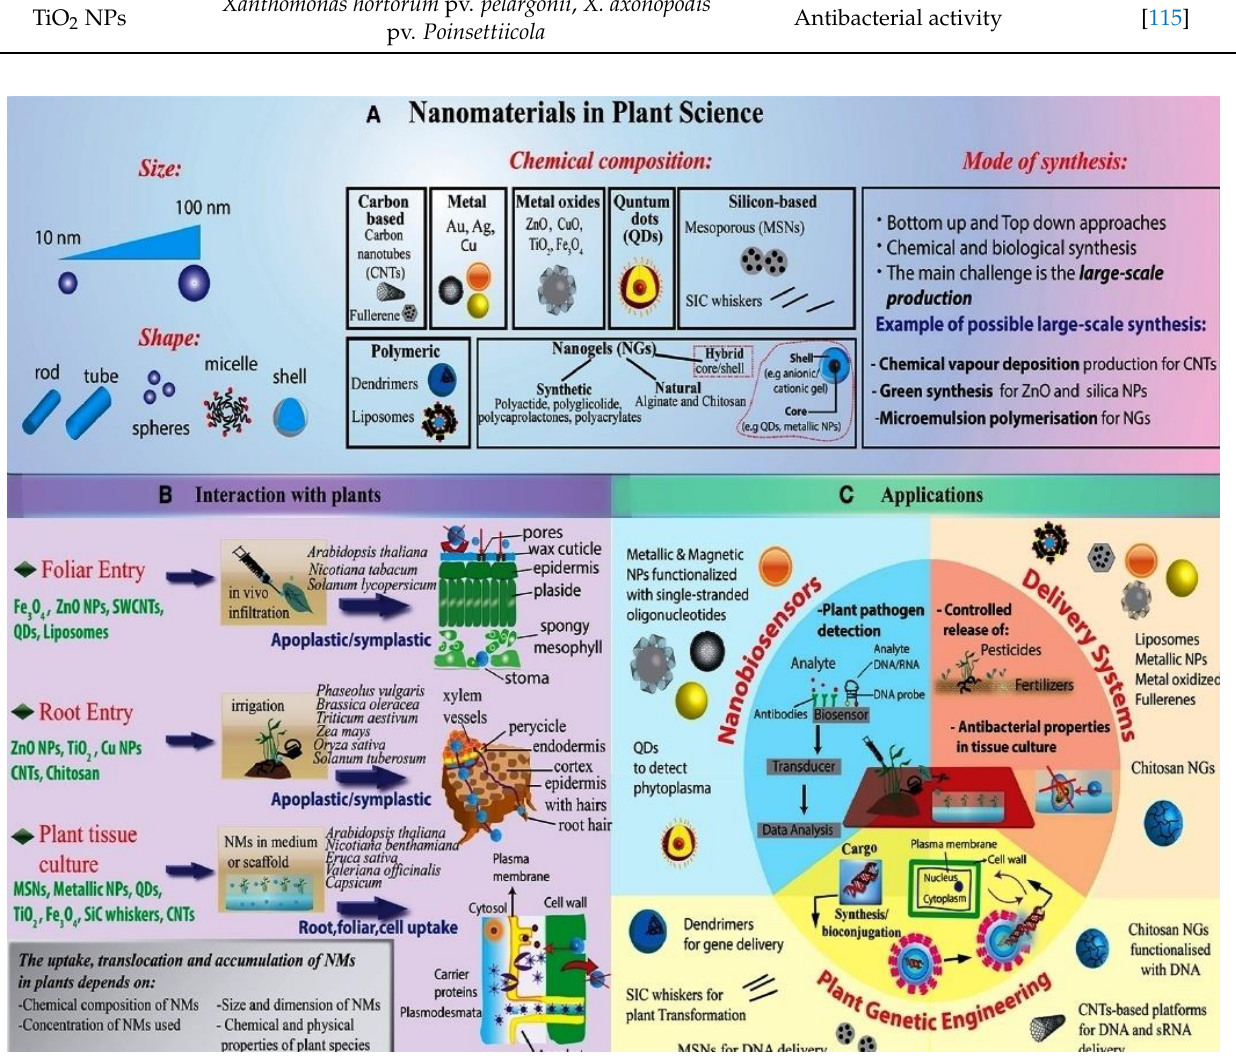
Figure 3. ( A ) Different types of nanoparticles. ( B ) Schematic presentation of delivery methods of different nanoparticles and translocation in plants. ( C ) Various applications of nanoparticles (Taken from Sanzari et al. [116]).